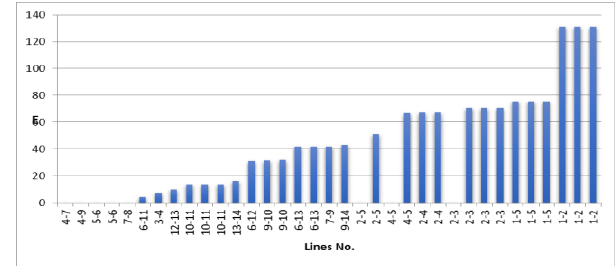
Fig6. Economic index after exclusion of inefficient line 4-5 Iteration 4: Exclusion of route 2-3 The average Ei of the system for existing number of lines from below figure after the exclusion of less efficient lines 2-5, 4-5 and 2-3 will be=1425.8/28= 50.92 = 49.1 . Fig.7 shows the chart for E of network with exclusion of route 2-3 from the i network.